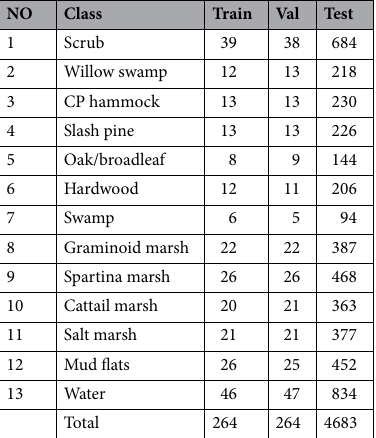
Table 1. Number of training, validation, and test samples for KSC